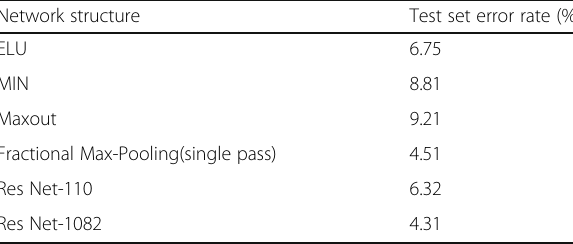
Table 3 Error rate of different network structures Network